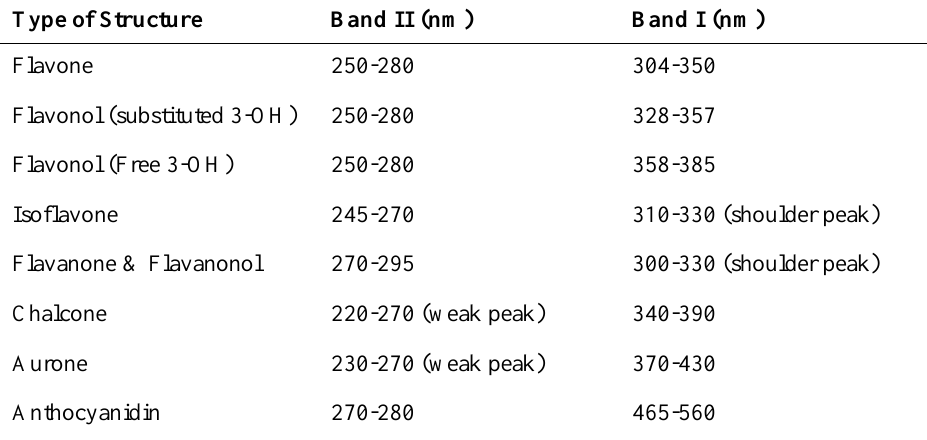
Table 2. Spectral characteristics of the UV‐VIS spectrum of Flavonoids [4] Type of